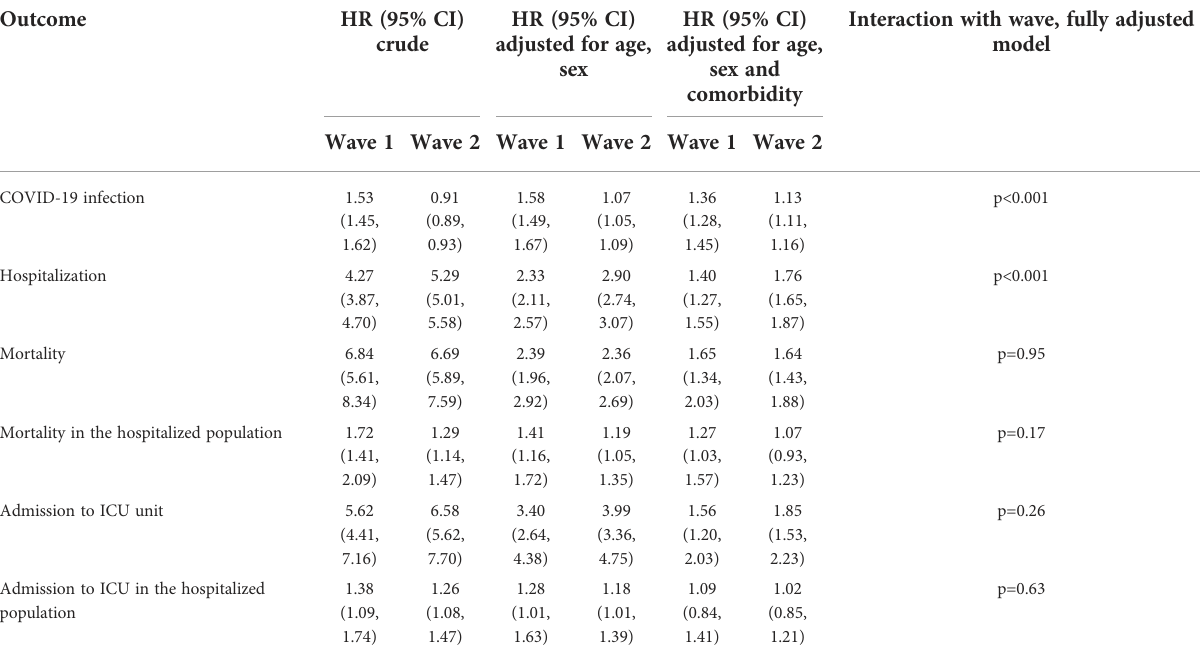
TABLE 3 Hazard ratio (HR) for persons with diabetes compared with persons without diabetes for COVID-19 related hospitalization, mortality, and admission to intensive care unit (ICU) in the whole Danish population, and COVID-19 related mortality and ICU admission in the hospitalized population